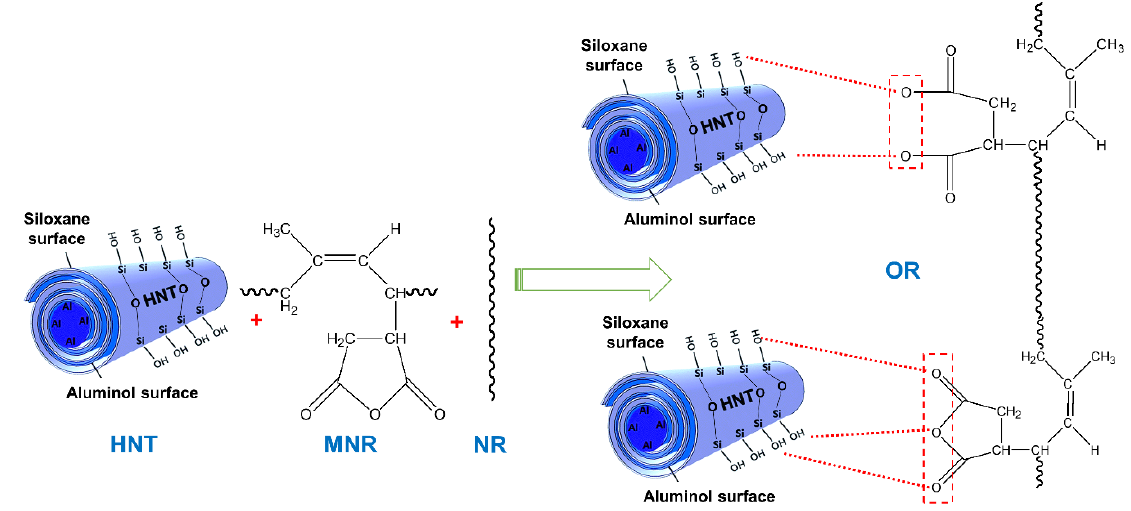
Scheme 1. Possible interactions between NR and HNT in the presence of MNR as compatibilizer.